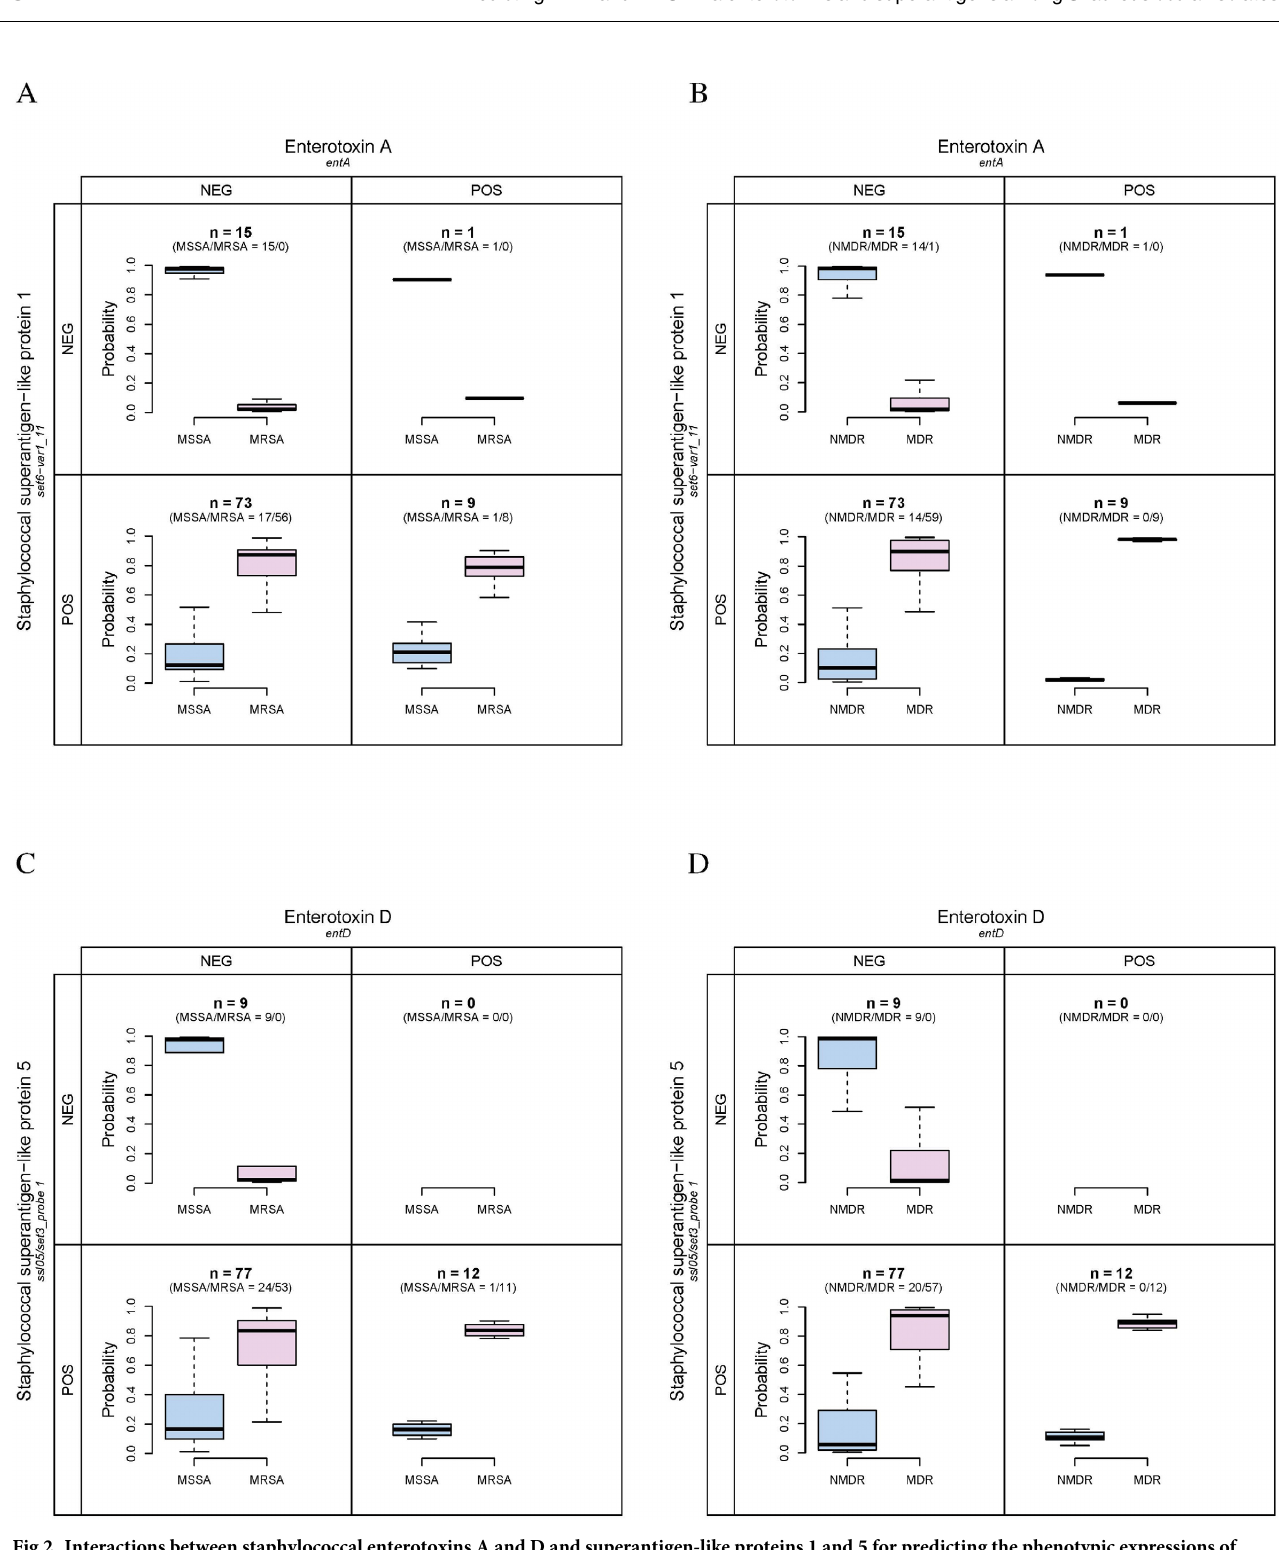
PLOS ONE | https://doi.org/10.1371/journal.pone.0254519 July 28,